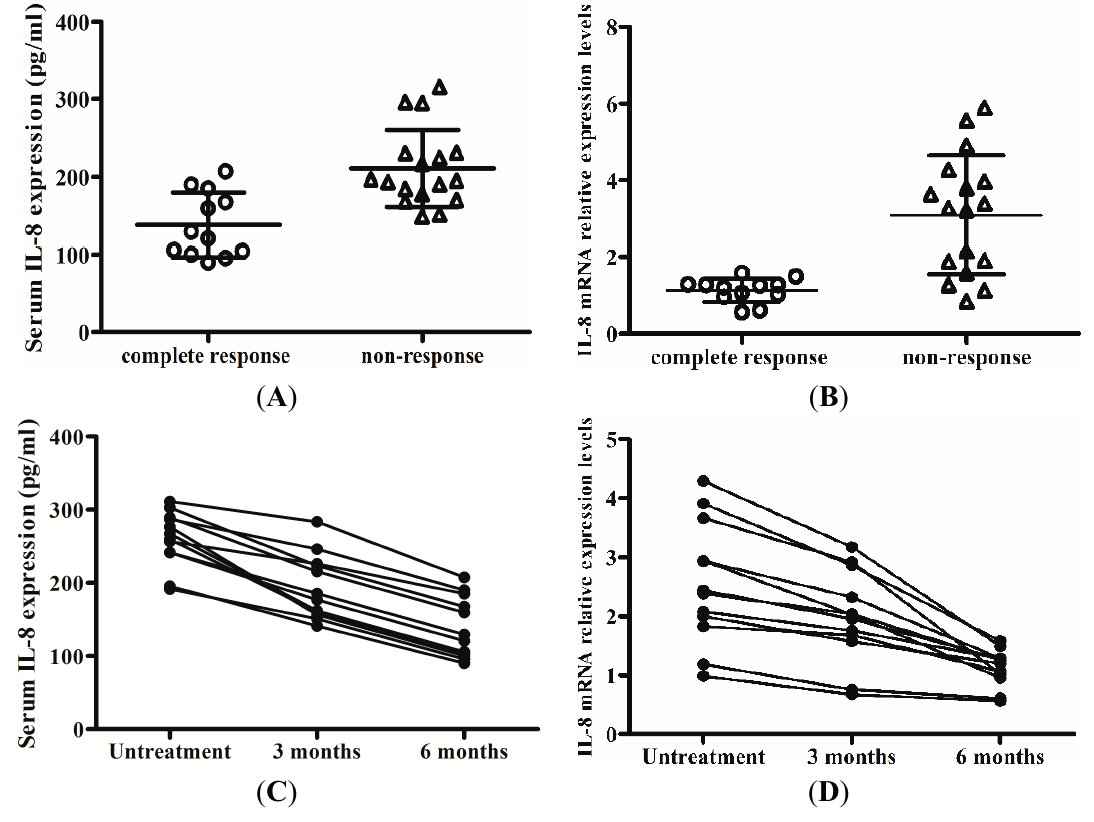
Figure 6. Expression of IL-8 in serum and PBMCs of patients who had a complete response compared to patients who did not respond to antiviral therapy by interferon-alpha (IFN- α ) during treatment. ( A ) Detection of serum IL-8 of the patients who had complete response vs. no response to antiviral therapy by IFN- α after treatment by ELISA; ( B ) Detection of IL-8 mRNA in PBMCs of the patients who had complete response vs. no response to antiviral therapy by IFN- α after treatment by RT-qPCR; ( C ) Detection of serum IL-8 of the patients who had complete response to antiviral therapy by IFN- α during treatment by ELISA; ( D ) Detection of IL-8 mRNA in PBMCs of the patients who had complete response to antiviral therapy by IFN- α during treatment by RT-qPCR; ( E ) Detection of serum IL-8 of the patients who had no response to antiviral therapy by IFN- α during by ELISA; ( F ) Detection of IL-8 mRNA in PBMCs of the patients who had no response to antiviral therapy by IFN- α during treatment by